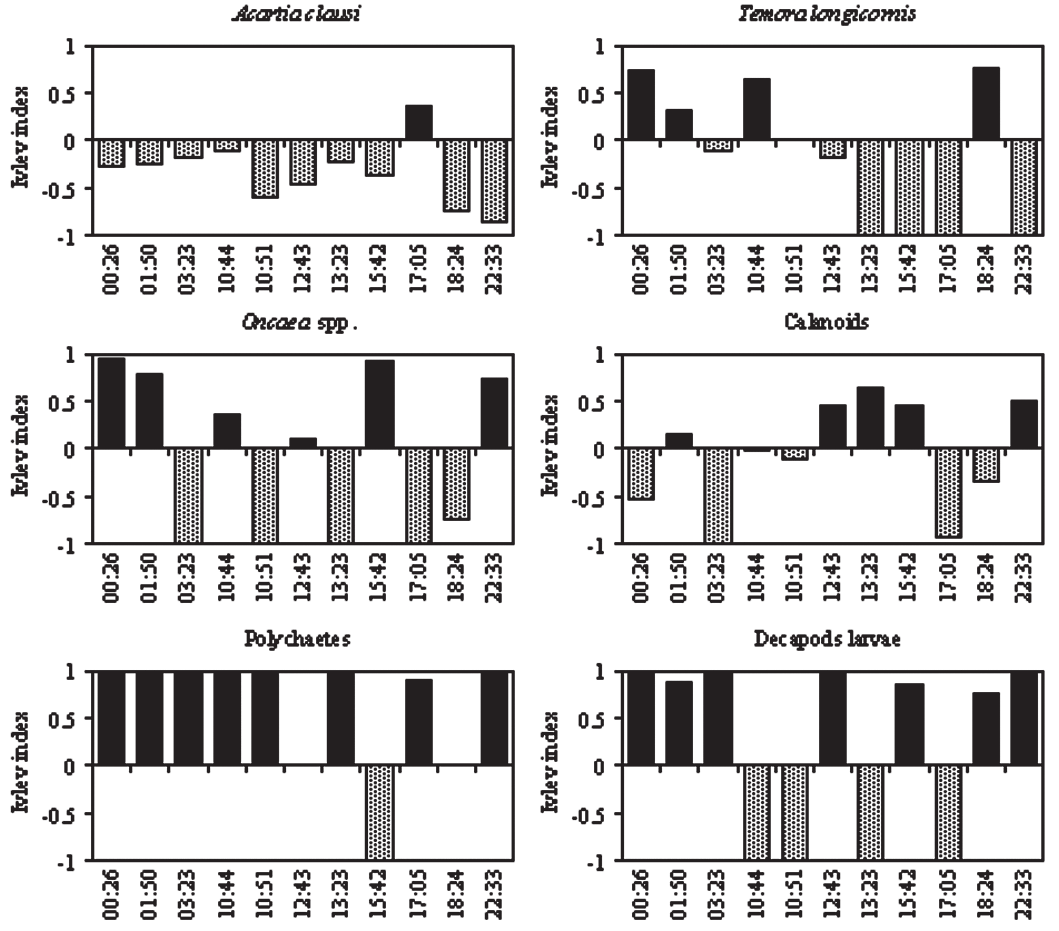
Fig. 6 . – Daily pattern of ivlev selection index (e) for each selected prey categories. the time of day (hh:mm) is on the